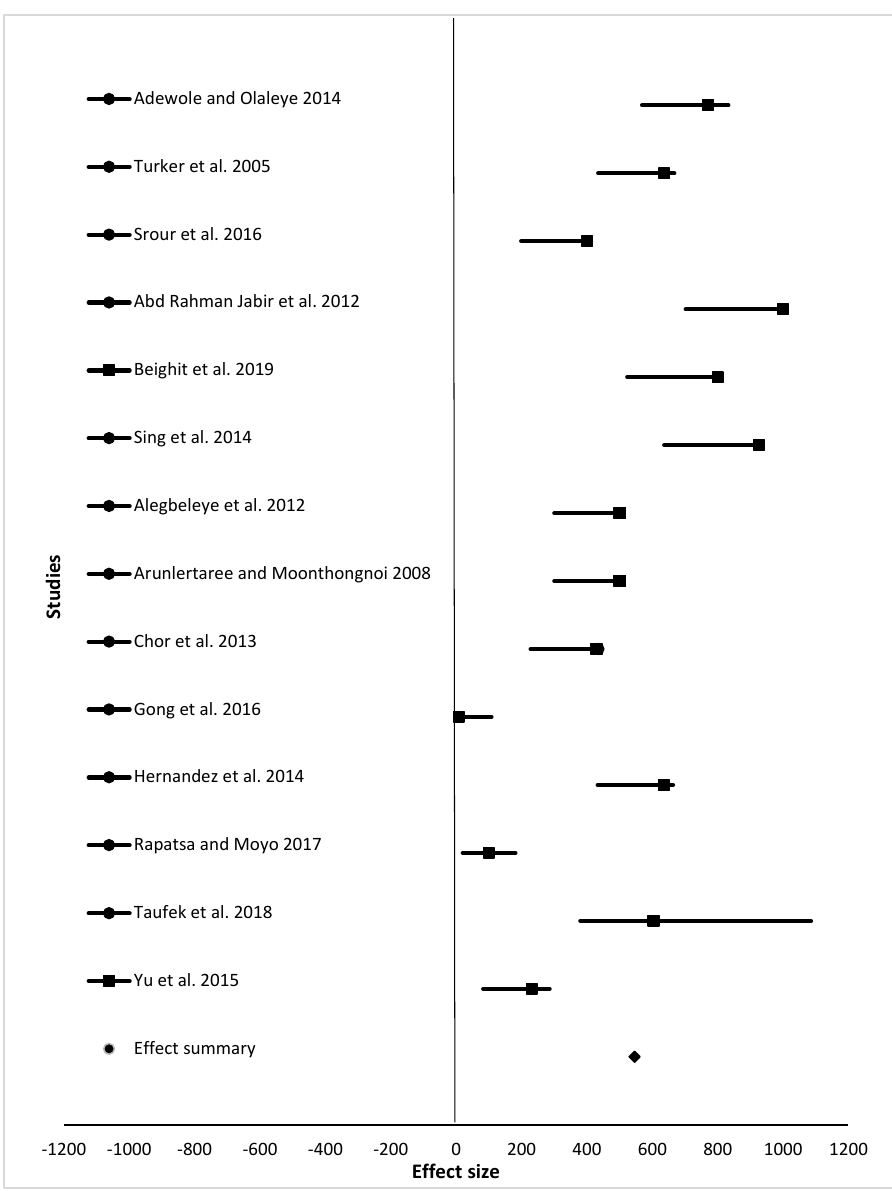
Figure 5. The effect size of survival rate (%) of fish from different studies fed different animal protein sources compared to fishmeal as a protein source.